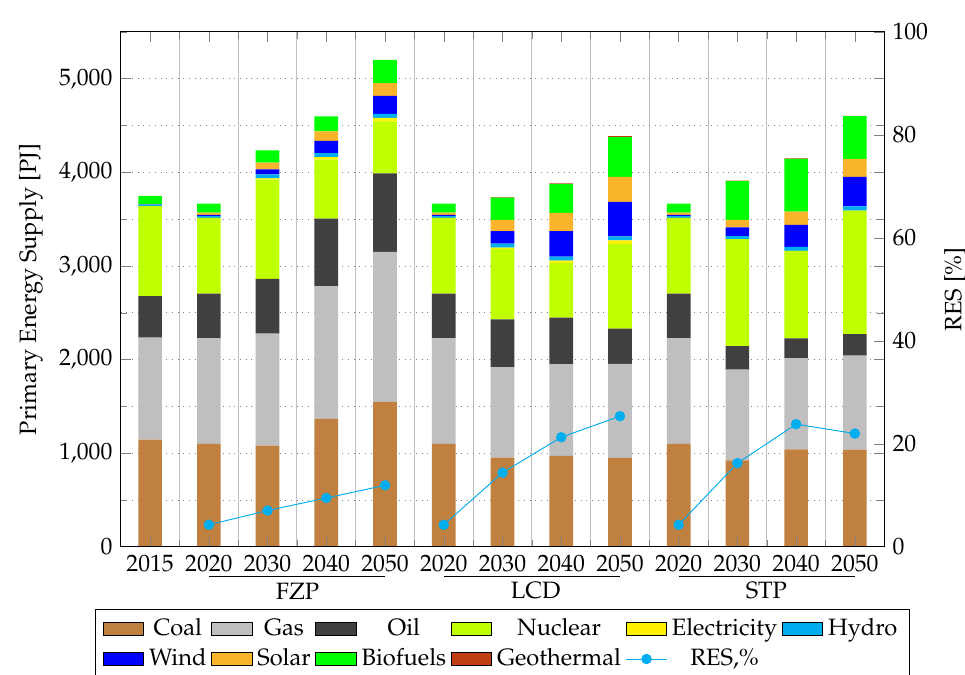
Figure 7. Total Primary Energy Supply for three main scenarios.